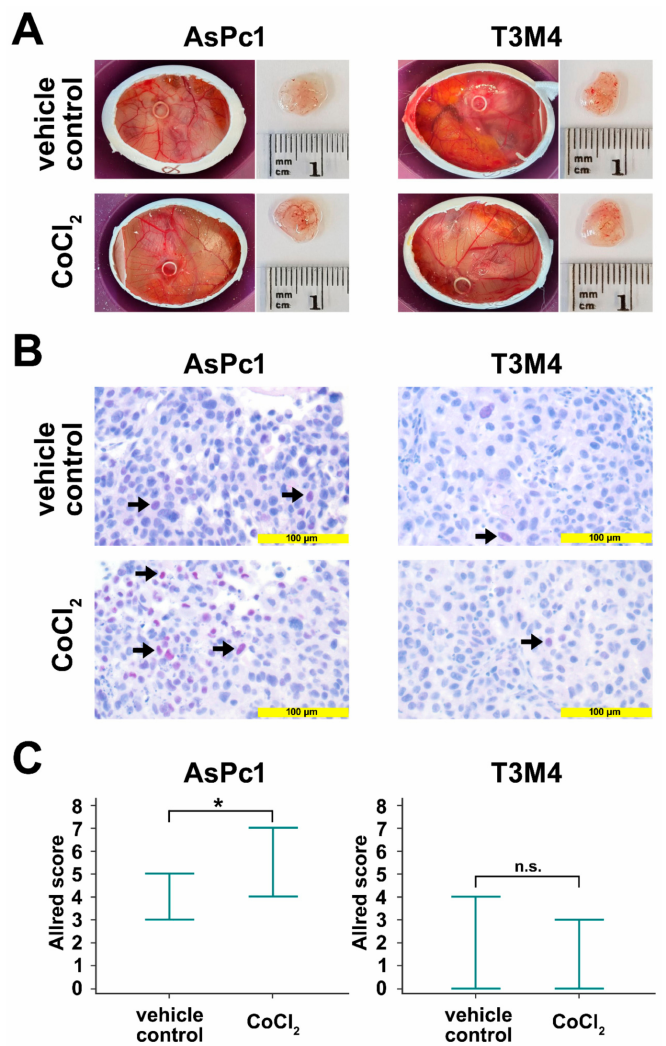
Figure 4. Avian xenografts model. ( A ) The three-dimensional growth of AsPc1 cells (treated, n = 7; untreated, n = 5) and T3M4 cells (treated, n = 4; untreated, n = 3) inoculated on the chorioallantoic membrane (CAM) of fertilized chicken eggs and the harvested tumors from vehicle control and after treatment with CoCl 2 were photographed at day 17 of embryonic development. Tumor volumes and weights were not significantly different between vehicle control and CoCl 2 -treated xenograft tumors. tumors. There was a significant induction of Blimp-1 expression following treatment with CoCl 2 in AsPc1 cells, but not in T3M4 cells. ( C ) Quantification of Blimp-1 expression in xenograft tumors. Markers indicate the range of Blimp-1 Allred scores. For AsPc1 cells, Blimp-1 Allred scores were significantly higher CoCl 2 -treated than for vehicle control xenograft tumors. No significant difference in Blimp-1 Allred scores was observed for CoCl 2 -treated T3M4 xenograft tumors compared to vehicle control. n.s., not significant; *, p <